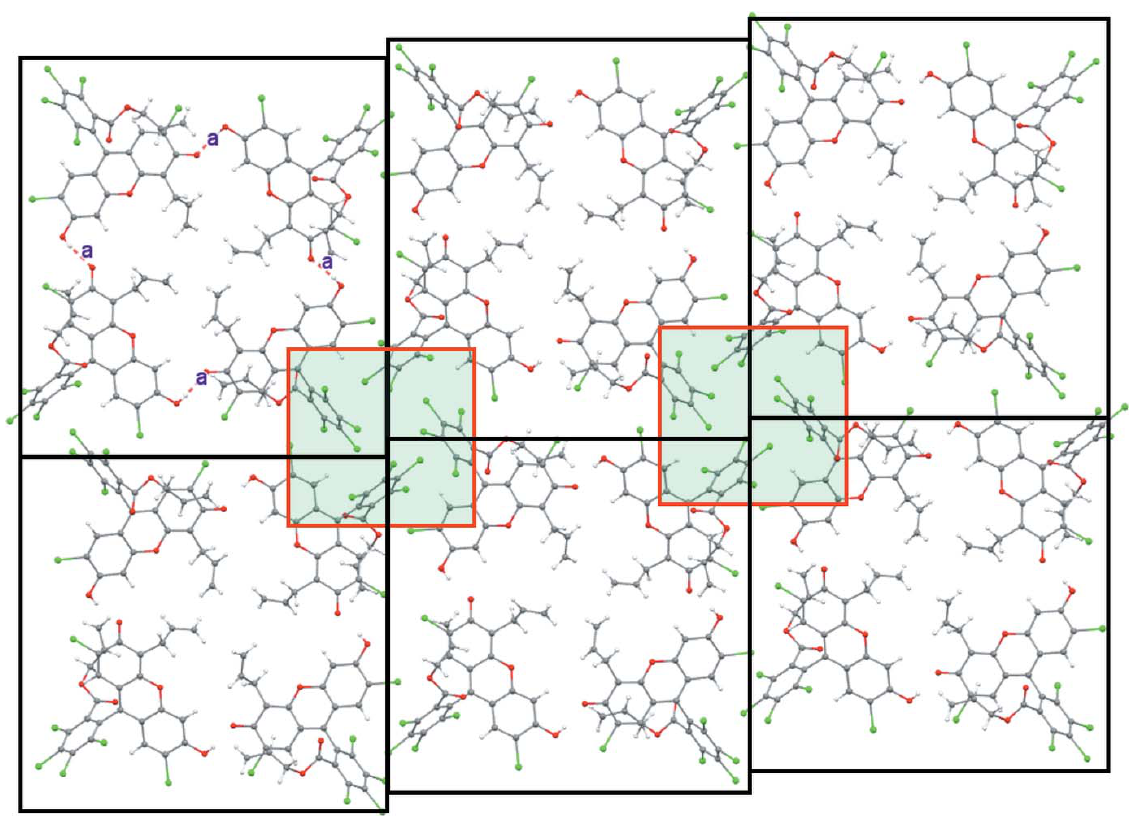
Figure 3 Infinite sheets formed by neighboring tetrameric aggregates via Cl (cid:2)(cid:2)(cid:2) (cid:2) interactions. The aggregates are shown as large black squares and the intermolecular interactions between them are shown as small red squares with a semi-transparent green